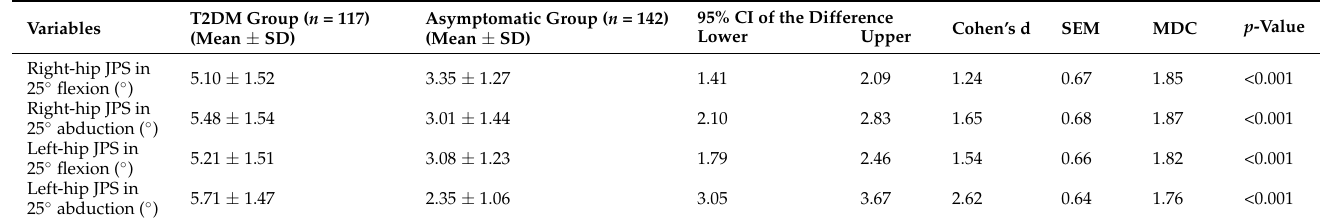
Table 2. Comparison of hip JPS between T2DM and asymptomatic group.